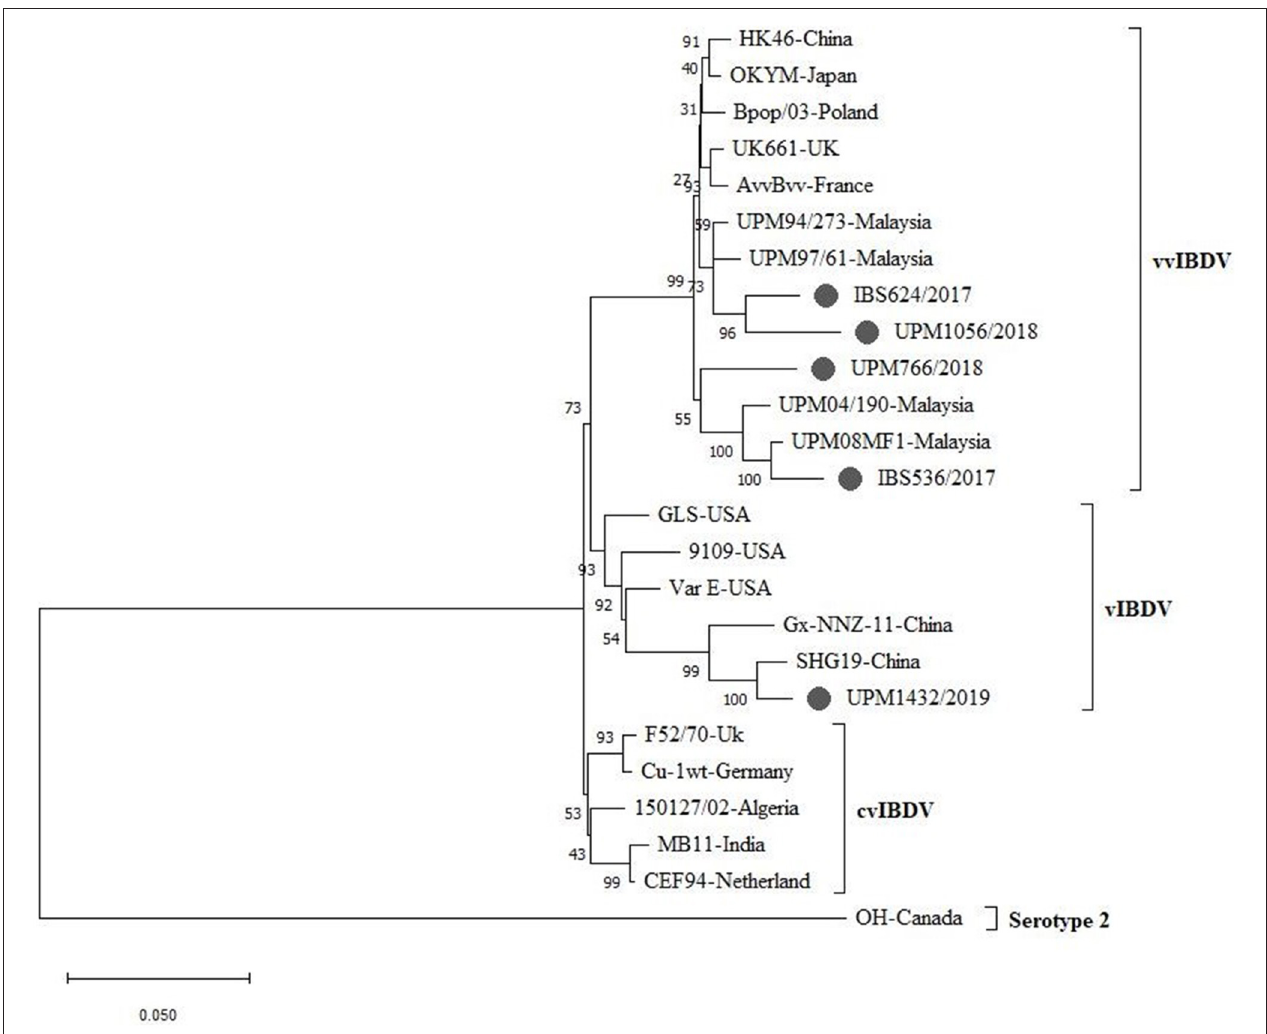
FIGURE 3 | Maximum Likelihood-based Phylogenetic tree of complete segment A genome of IBDV using 3,260 nucleotides fragment with the General Time Reversible model with Gamma distribution. Each cluster is indicated with a different color. Bootstrap = 1,000 replicates. The filled circles indicate strains identified in this study.